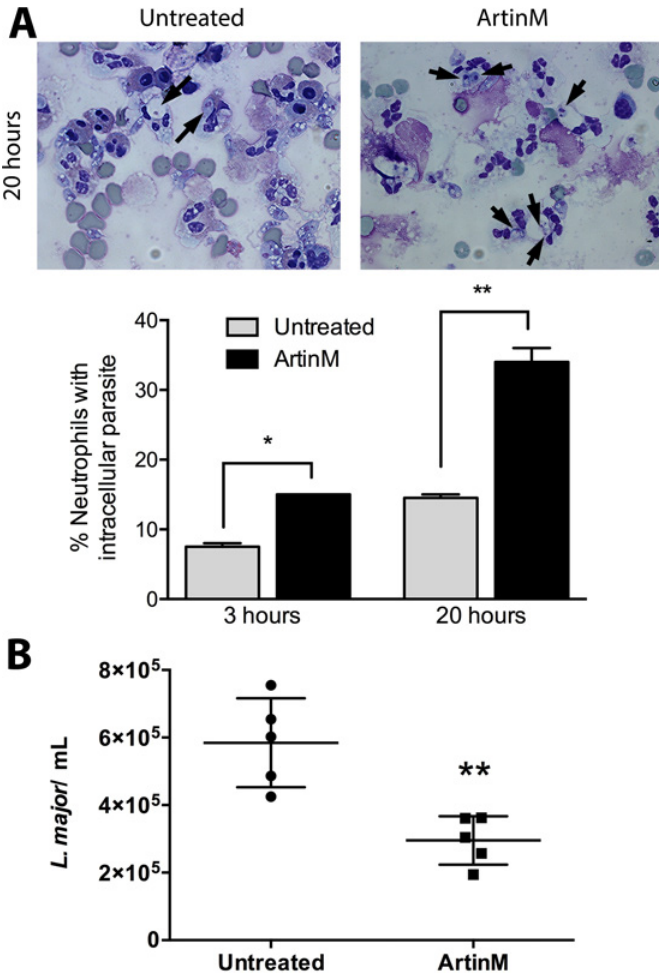
Fig 1. ArtinM enhances L . major uptake and killing by human neutrophils. Human neutrophils were treated or were not treated with ArtinM, and infected with L . major promastigotes (MOI 3:1). A – L . major uptake. After incubation for 3 and 20 h, the cells were centrifuged on slides and stained for evaluation by light microscopy. Arrows indicate internalized parasites. In the graphic, data are expressed as the mean of neutrophils with intracellular parasites ± SD. * p < 0.05; ** p < 0.01 in comparison to untreated cells at the same period. One way ANOVA followed by Bonferroni's post-test. B – L . major killing. After 3 h of infection the cultures were washed to discard uninternalized parasites, fed with Schneider`s medium and cultured for additional 48 h. Motile promastigotes were counted, and the data are expressed as mean of viable parasites ± SD. ** p < 0.002: compared to untreated, Student t test. Each assay was carried out in triplicate. The shown data are representative from three different